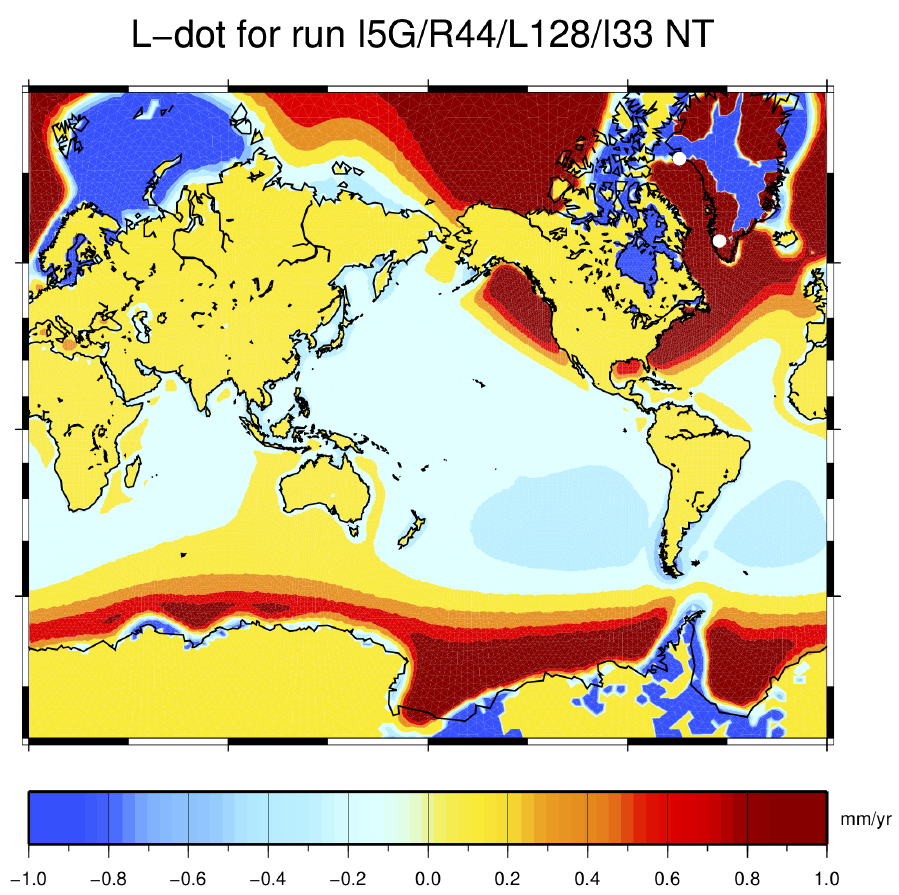
( ω ) , in units of Figure 7. GIA fingerprint for the present-day rate of variation of the surface load ˙ L > e = 0.00 mm year − 1 to a very high mm year − 1 of water equivalent. The whole-Earth average is < ˙ L precision. In oceanic areas, ˙ is strongly correlated with ˙ in Figure 3. In continental areas, ˙ only L S L takes contributions in regions where, according to ICE-5G (VM2), ice thickness variations are still occurring or where the OF is still varying. These conditions are met in Greenland, where ˙ shows the L extreme values (white dots), and in West Antarctica,